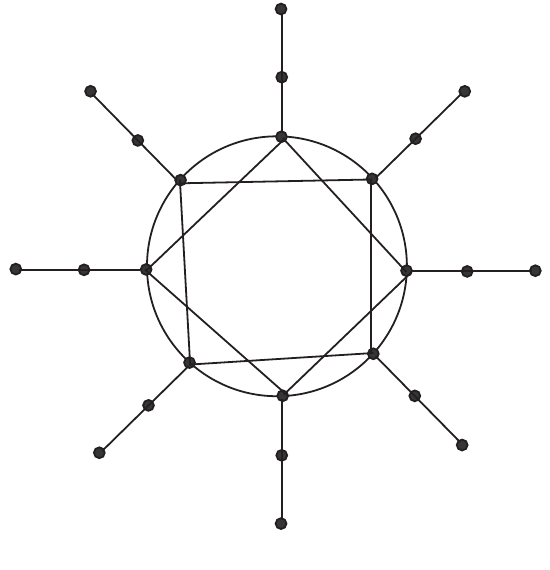
Figure 2. The graph H 4,8 ( P 3 )